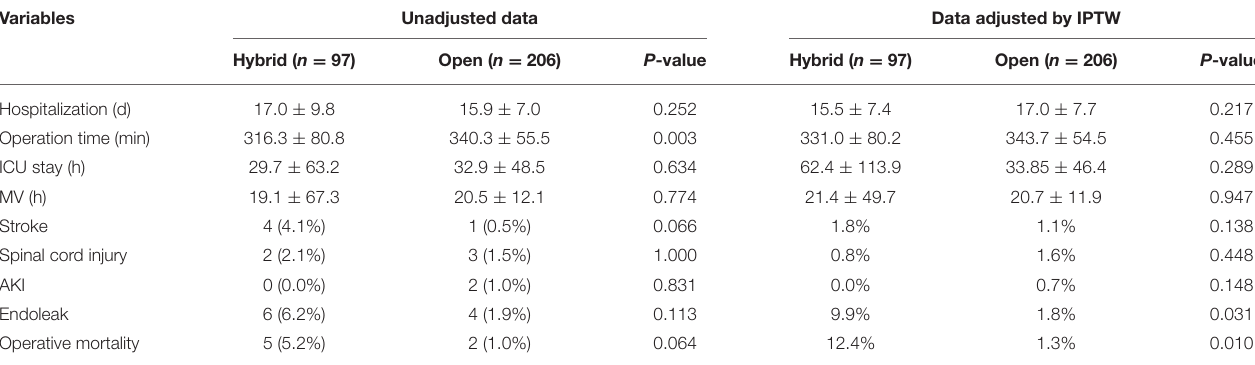
TABLE 2 | Postoperative outcomes comparisons before and after